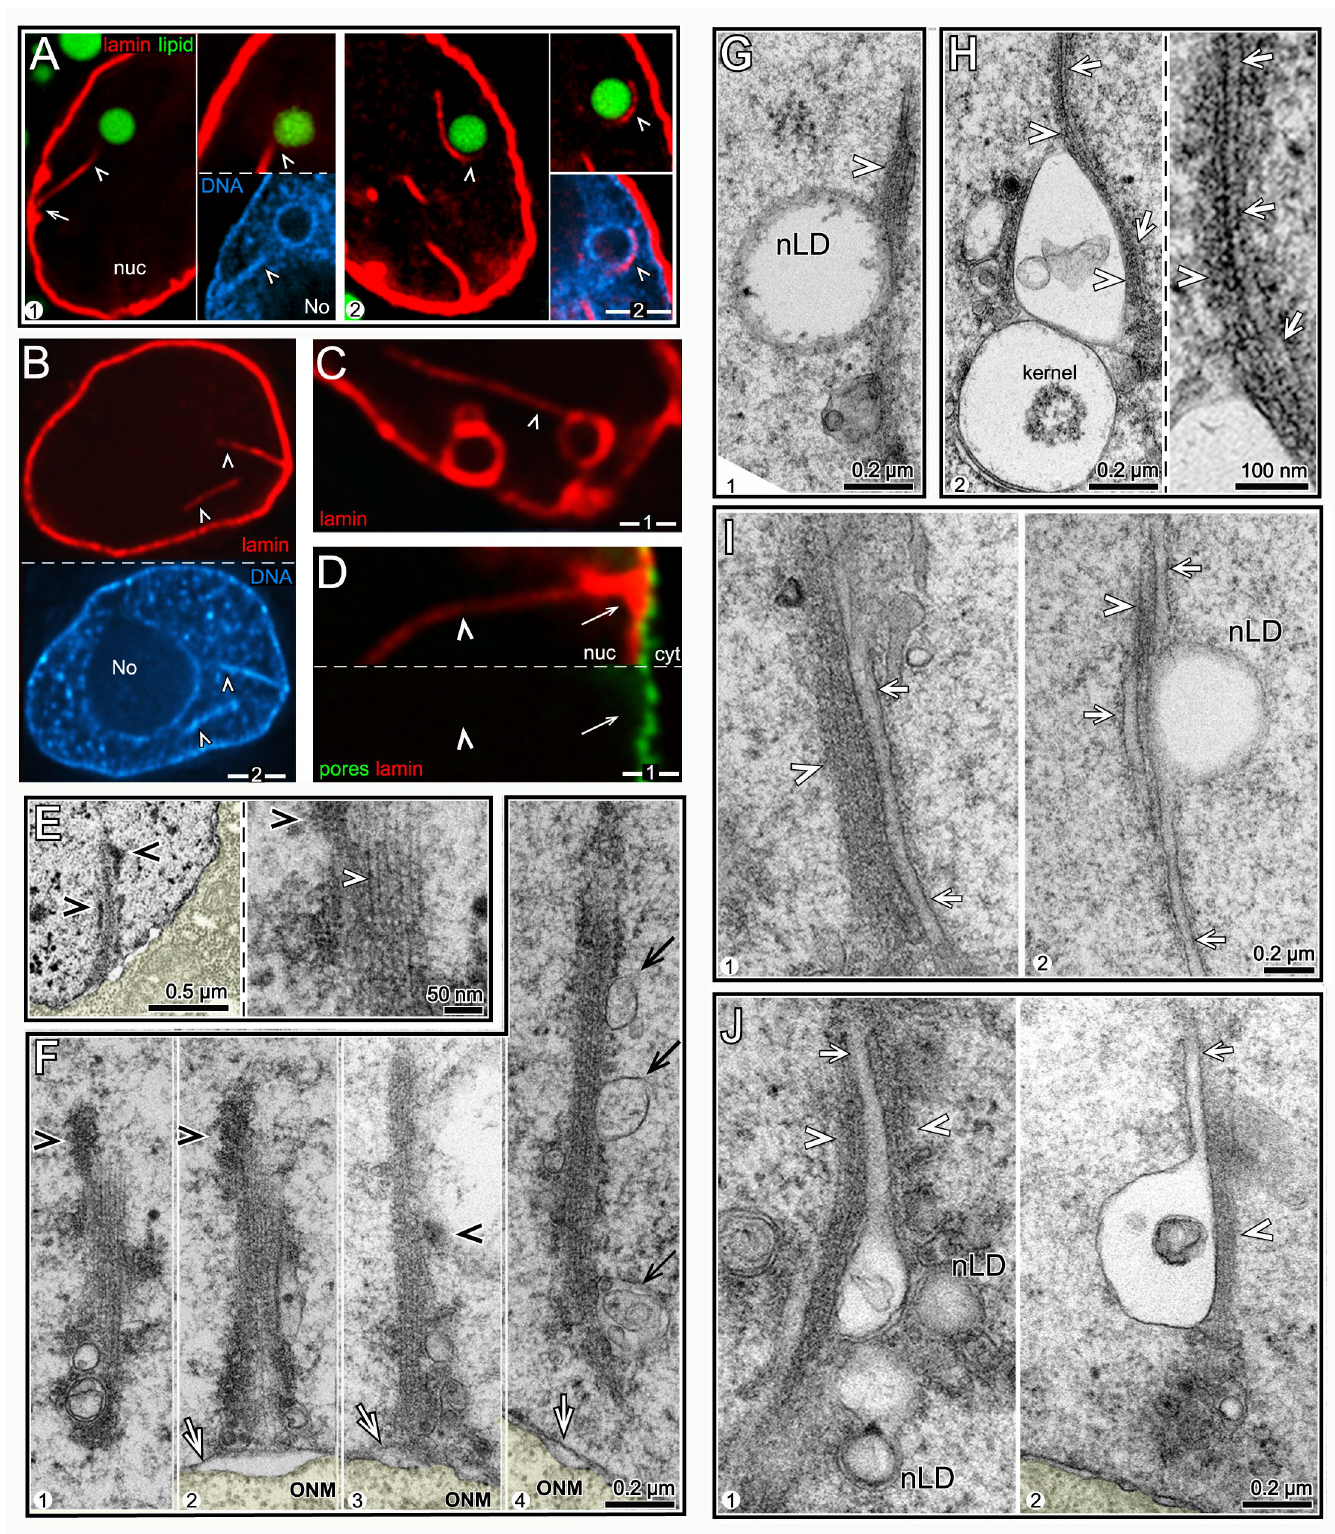
Fig 3. nLDs and nuclear microfilament bundles (nMFBs). (A) Examples of lamin lines (arrowheads; red, LMN-1/lamin) and nLDs (green, BODIPY) in two D1 nuclei. The lamin line in panel 1 extends between the envelope (arrows) and the nLD (top inset). The bottom inset in panel 1 shows that both the nLD and the lamin line